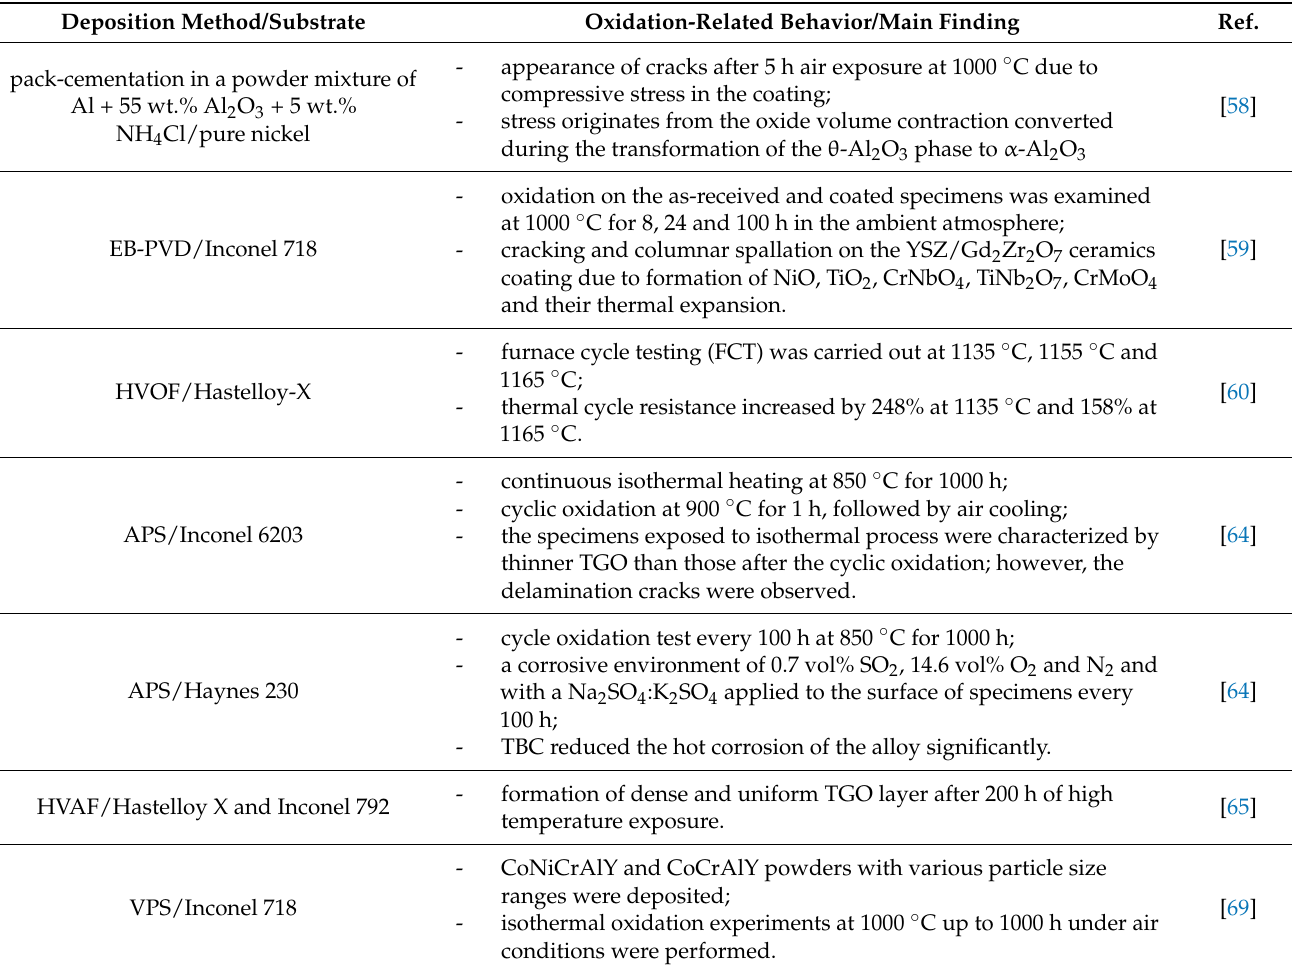
Table 1. Summary of the oxidation performance depending on the deposition method applied. Deposition Method/Substrate Oxidation-Related Behavior/Main Finding